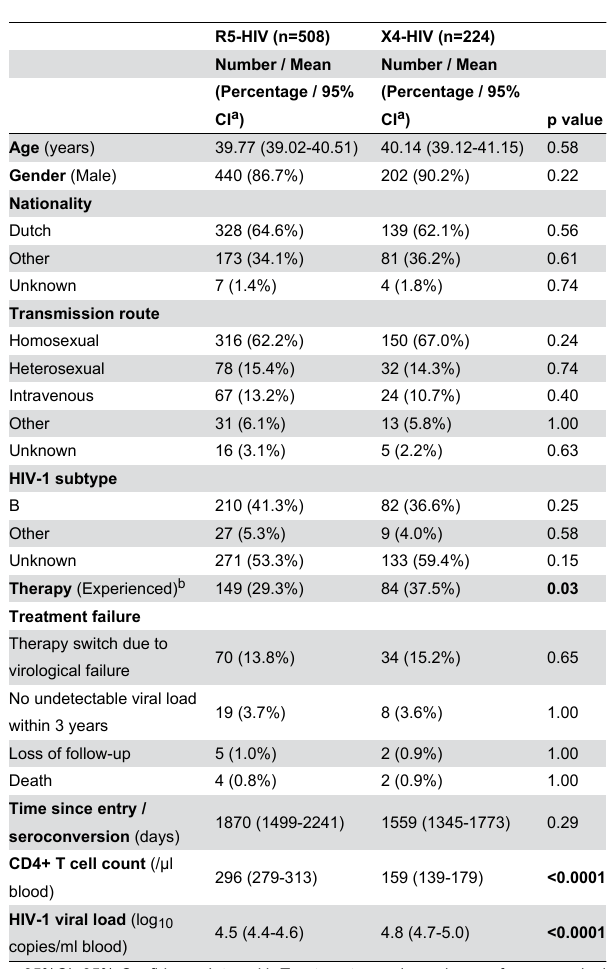
Table 1. Baseline characteristics of patients with or without X4-HIV variants prior to start of